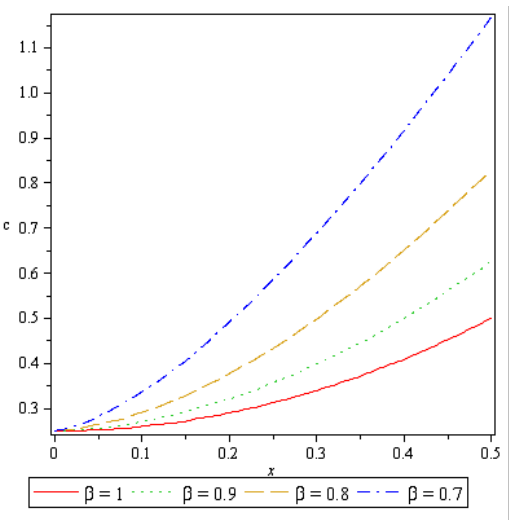
Fig. 5: 3 rd order approximation HAM ( q -FHATM, n = 1 ) solution c ( x , t ) verses space x for Eq. (40) at t = 0.5, (cid:126) = −1 with different values of β